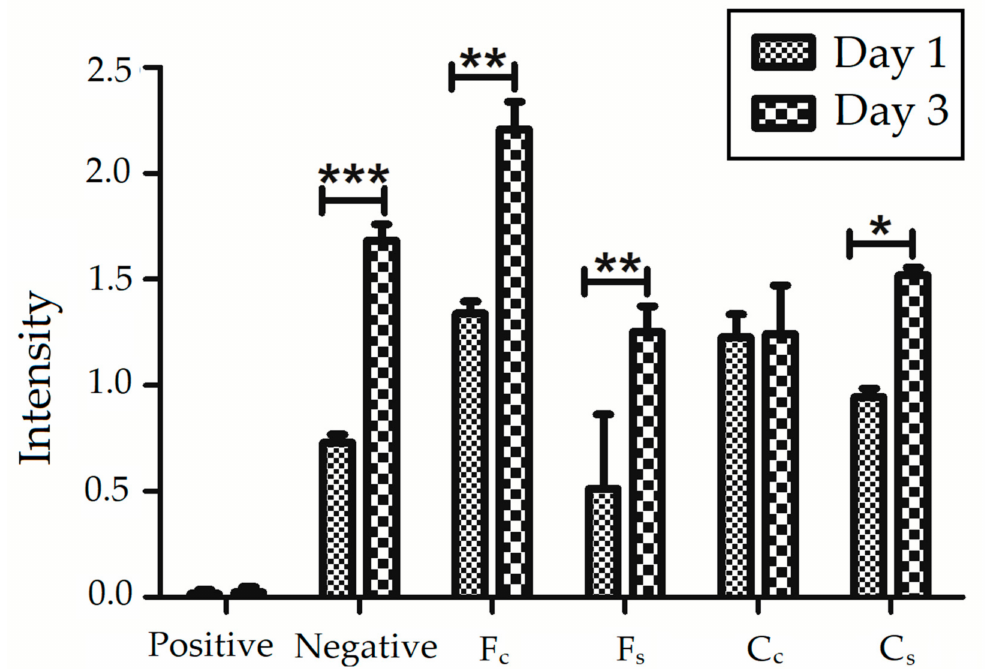
Figure 8. XTT assay of cellulose powders (C c and C s ) and fabricated alcogel fibers (F c and F s ). The cell viability was observed in all samples; (***, p < 0.001; **, p < 0.01; *, p < 0.05). Negative samples were polyethylene and positive samples were DMSO. All test samples showed proliferation from day 1 to 3 except C c